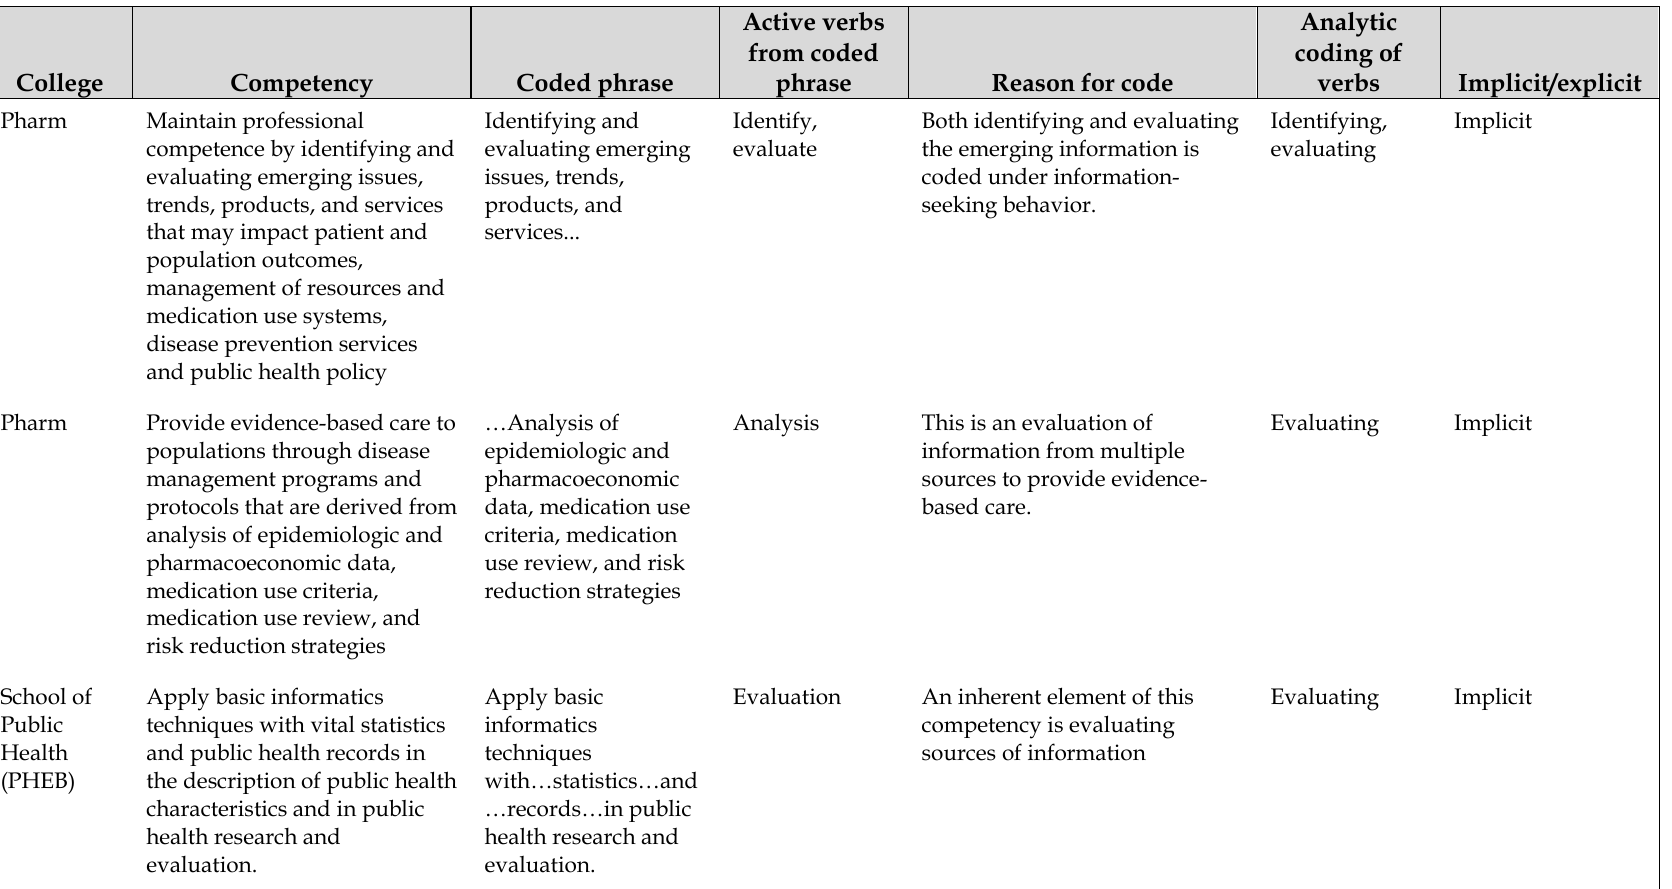
Table 2 Competencies with implicit or explicit information skills and behaviors